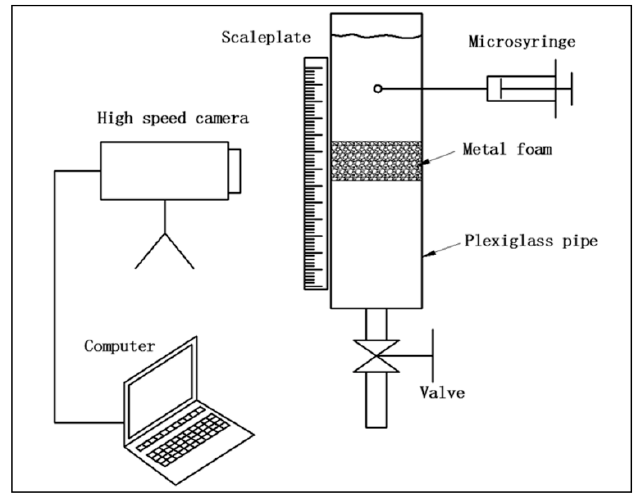
Figure 1. Setup for measurements on the hydrodynamics of a droplet passing through a metal